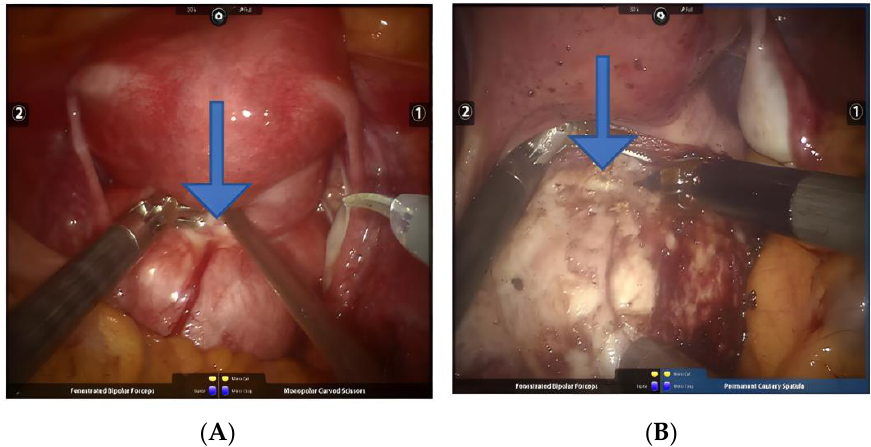
Figure 8. ( A , B ) Resection of cervical fibroids. Arrows point to the location of the cervical fibroids.